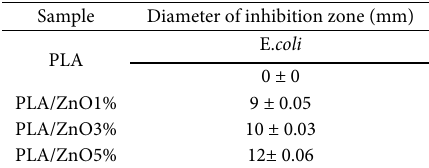
Fig 1. The inhibitory effect of poly-lactic acids containing nano-zinc oxide E. col